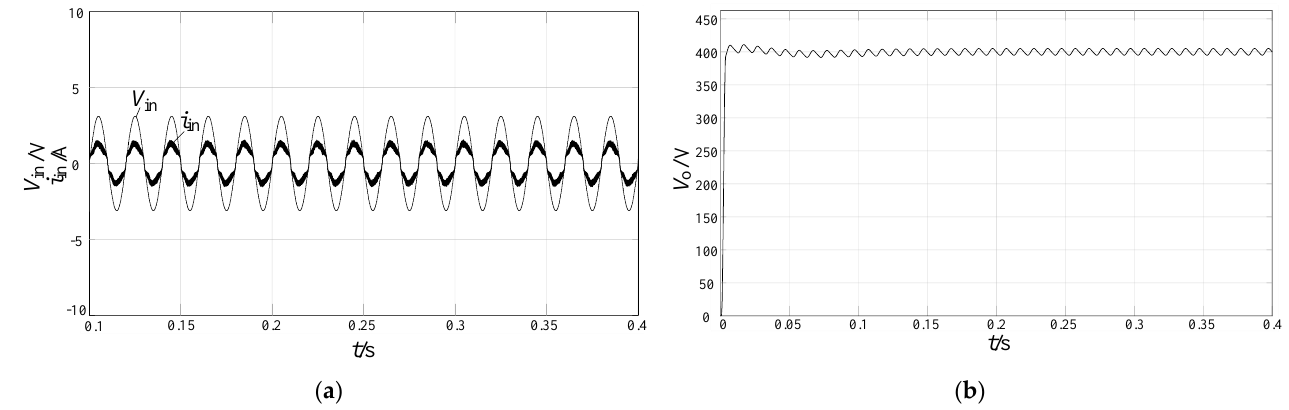
Figure 10. Input voltage, current, and output voltage waveforms of bridgeless PFC converter without power decoupling circuit: ( a ) input voltage and input current; ( b ) output voltage.